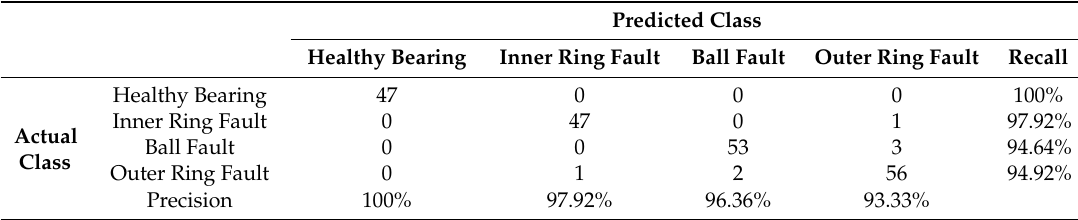
Table 6. Classification rate for Back-Propagation neural network (Testing data).